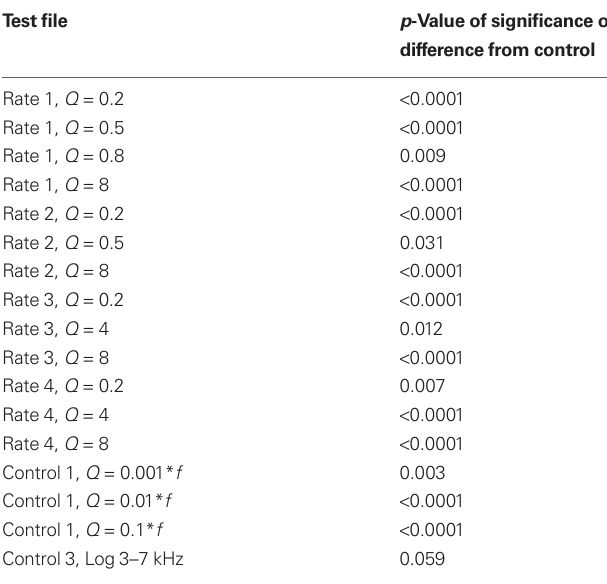
Table 1 | Table of significant p -values for pair-wise comparison with one-sided multiple comparison Dunnett correction for data in Figure 4 after one-way